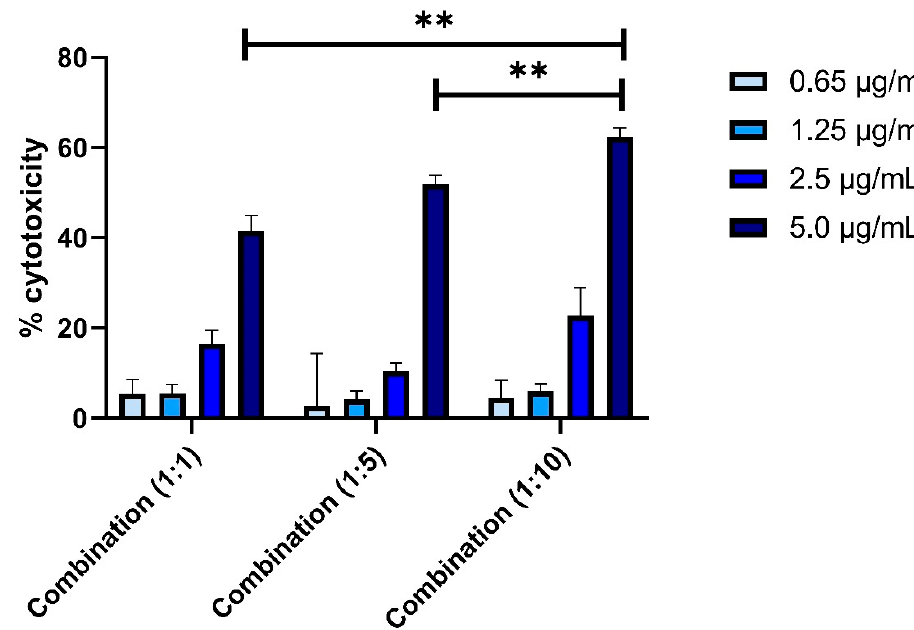
Figure 2. Cytotoxicity of TAM and RES combination in different ratios (1:1; 1:5; 1:10). Data are given as mean ± standard deviation ( n = 3) with statistical difference at (**) p < 0.01.